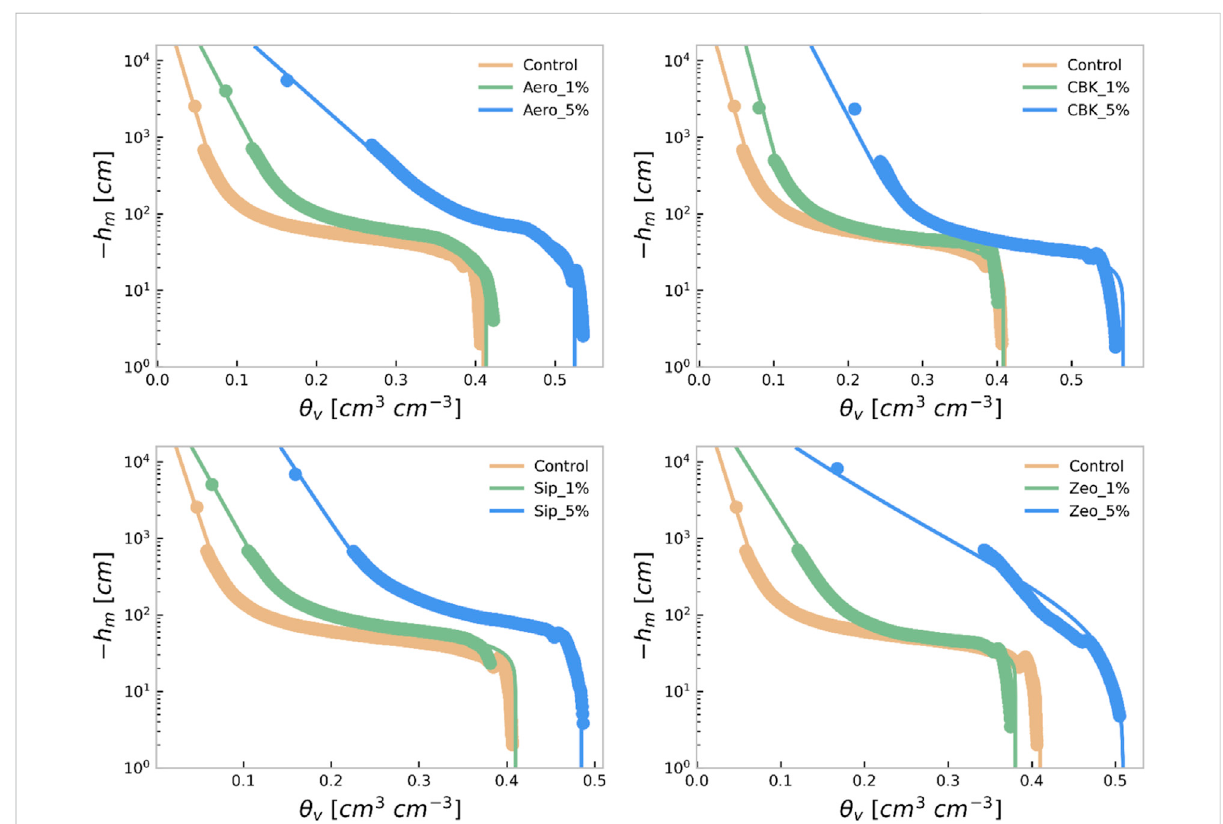
FIGURE 1 Different ASi amendments increase soil water holding capacity of sandy soil. The dots are the measured retention curves, and the lines are the estimated retention curves based on the PDI model. Under soil drying conditions, different ASi amendments increased s oil water content ( θ v ) at any givensoilmatricpotential( h m ).TheresultsofdifferentASiamendmentsontheretentioncurveofpurequartzsandaregiveninSupplementaryFigure S1 as supplementary